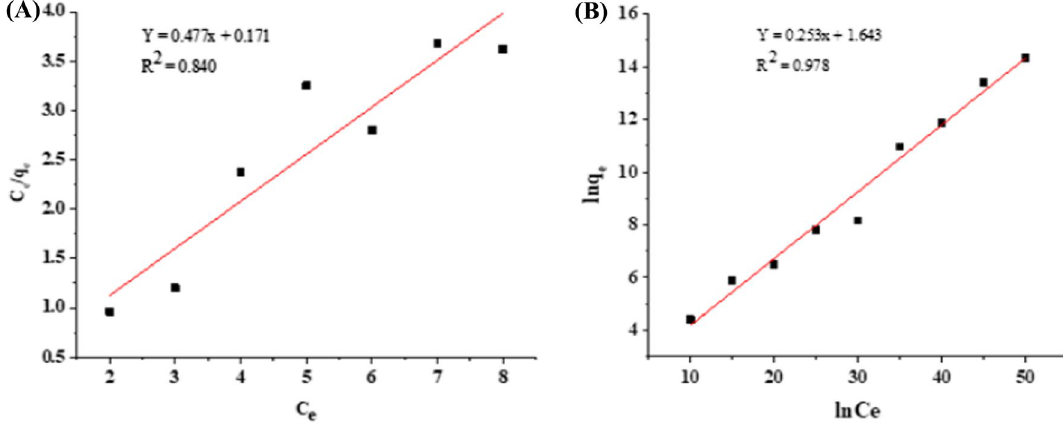
Fig. 5 MO adsorption data fitted to Langmuir A and Freundlich B isotherms at 25 °C